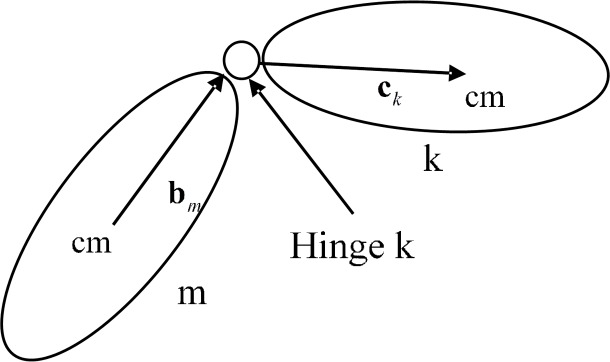
Inscribed object.